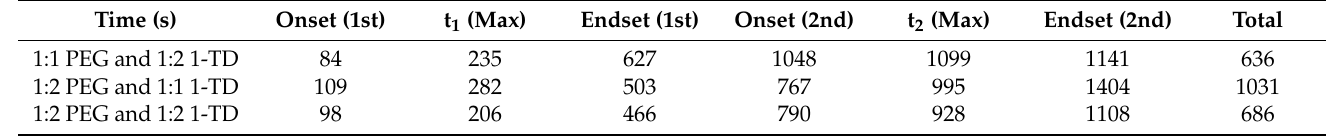
Table 6. Results of LED bulb during